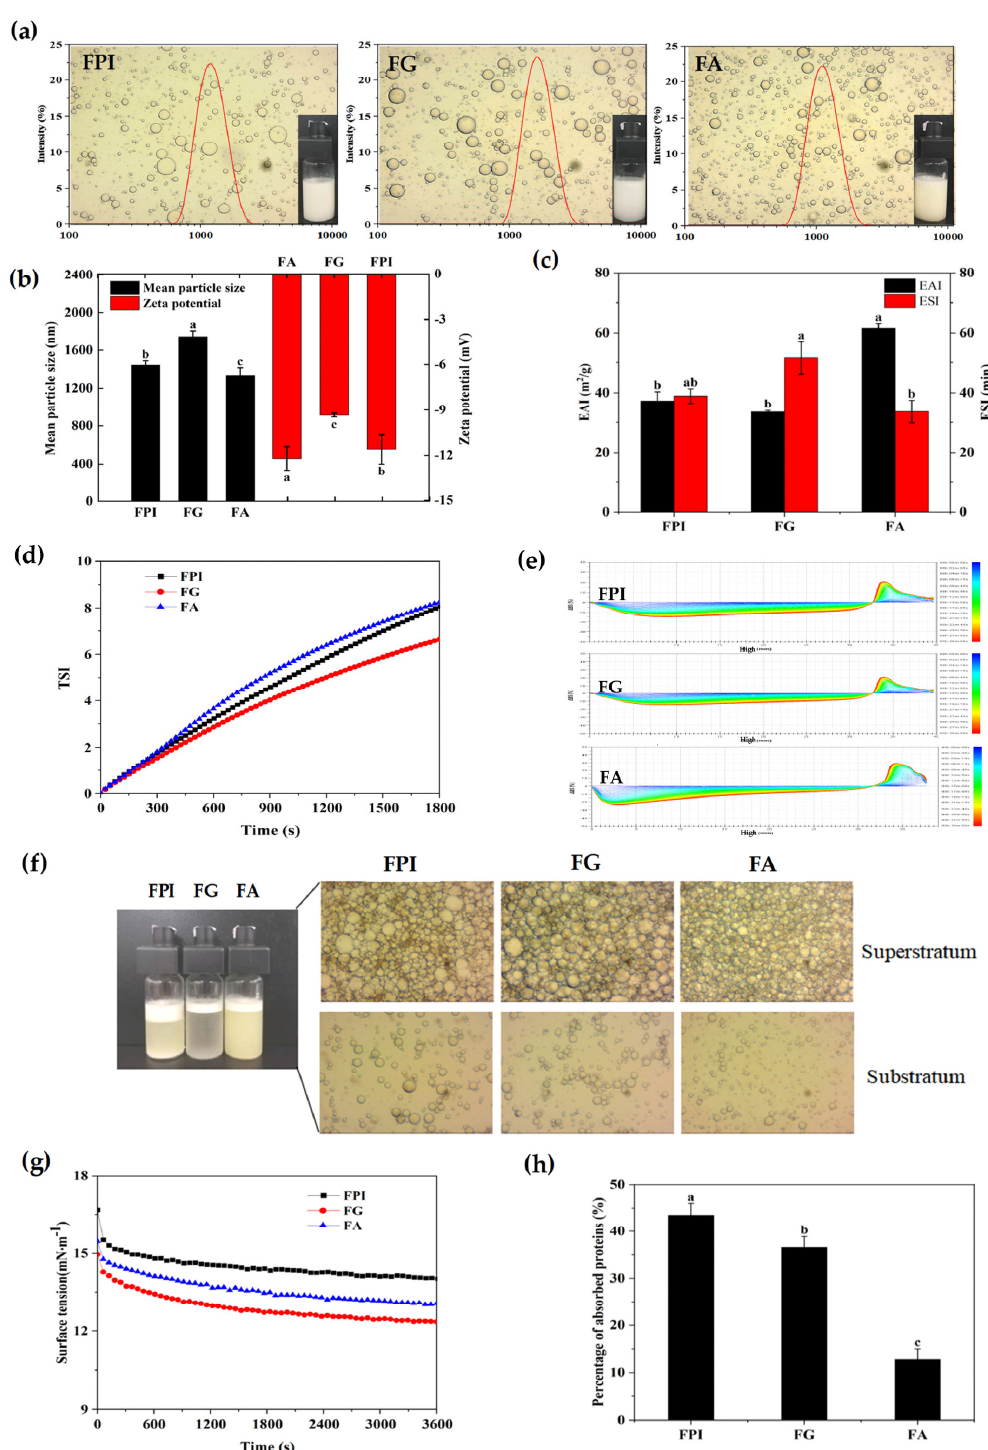
Figure 4. The physicochemical stability of emulsions constructed by FPI, FG, and FA. ( a ): the visual observation, optical micrographs, and particle size distribution; ( b ): the mean particle size (black bar) and zeta potential (red bar); ( c ): the EAI (black bar) and ESI (red bar); ( d ): the Turbiscan stability index (TSI); ( e ): the delta backscattering ( Δ BS) curves; ( f ): the optical micrographs (stored at 4 °C for 48 h); ( g ): the surface tension at the oil–water interface; ( h ): the percentage of adsorbed protein fractions. Different alphabets in the same index indicated significant differences at the p < 0.05 level. FPI: flaxseed protein isolate; FG: flaxseed globulin; FA: flaxseed